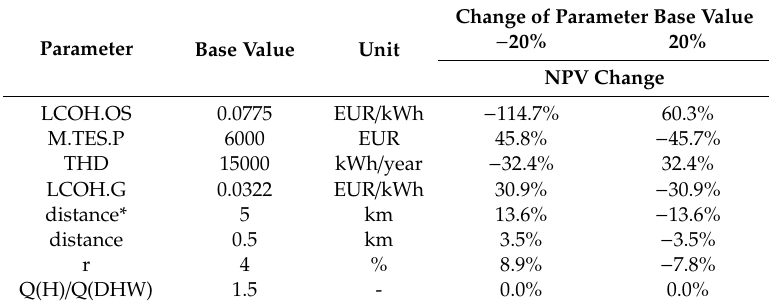
Table 1. NPV sensitivity analysis.